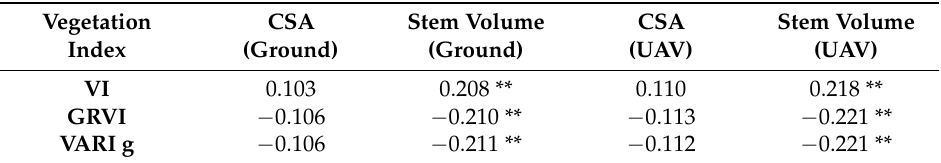
Table 5. The Pearson correlation coefficient between the different vegetation indicators derived from UAV and tree attributes at the level of individual trees. VI: vegetation index; GRVI: green-red vegetation index; and VARI g: vegetation atmospherically resilient index, green.